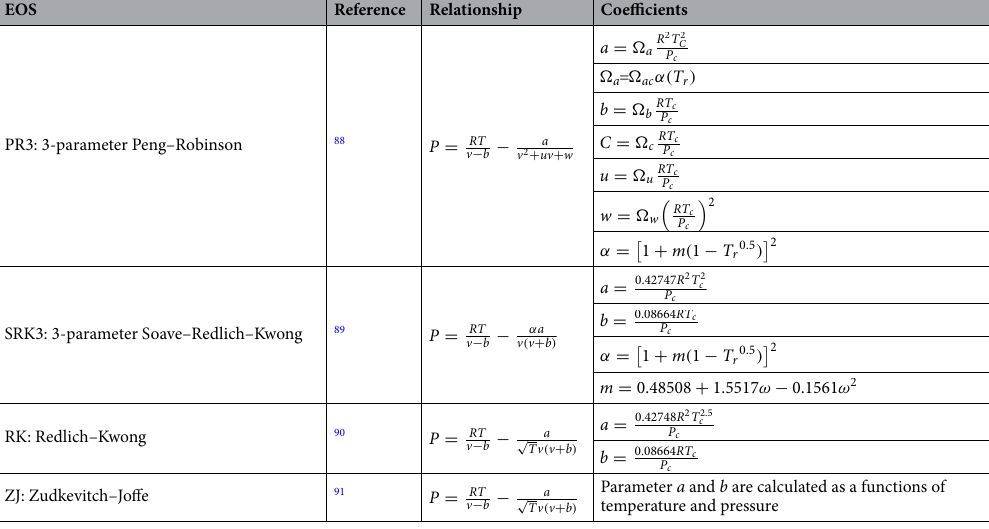
Table 4. Equations of state applied in this